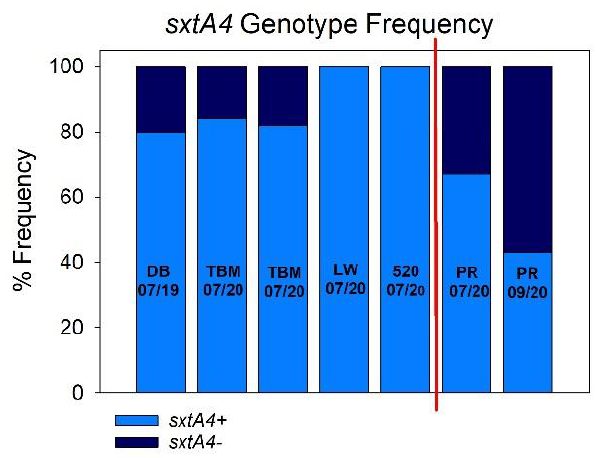
In the IRL, the frequency of the sxtA4+ genotype ranged from ca. 80–100% (Table 3, Figure 3). Sampling at Diamond Bay (July 2019) showed the sxtA4+ genotype to occur at 80% frequency. Comparable numbers were obtained for samplings at Telemar Bay Marina in 2020 in both June and July, with the sxtA4+ genotype occurring at frequencies of 81% and 84%, respectively. The sxtA4+ genotype occurred at a frequency of 100% in populations from sites LW and 520. The sxtA4+ genotype occurred at a much lower frequency in Mosquito Bay (Puerto Rico) populations, at ca 67% in July and decreasing to ca 40% in Sept (Figure 3). While these data must be interpreted with caution due to the low sample size, these are the first data demonstrating the presence of sxtA4 in P. bahamense populations in bioluminescent bays in Puerto Rico.